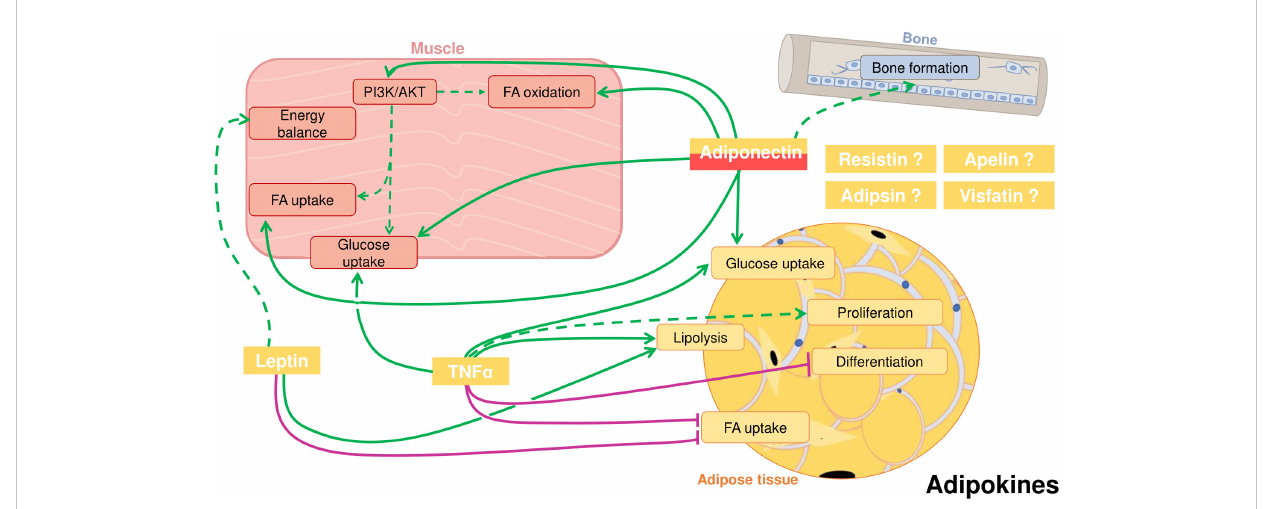
FIGURE 1 Crosstalk between adipose tissue, muscle, and bone in fi sh through cytokines secreted by the adipose tissue, also known as adipokines. Adiponectin, that can also be secreted by skeletal muscle, can positively in fl uence in muscle fatty acid (FA) and glucose uptake, FA oxidation and activate the PI3K/AKT pathway. Studies suggest a role for adiponectin inducing bone formation. Adiponectin has also autocrine functions in the adipose tissue, where it can promote glucose uptake. Leptin in muscle can presumably in fl uence energy balance. In the adipose tissue, leptin induces lipolysis and inhibits FA uptake. Tumor necrosis factor a (TNF a ) can stimulate glucose uptake in muscle and has an important autocrine role in adipose tissue. There, TNF a stimulates glucose uptake and lipolysis, and probably adipocyte proliferation, whereas it inhibits differentiation and FA uptake. Other potential adipokines are resistin, apelin, adipsin and visfatin. Positive proved effects: green solid line; Positive suggested effects; green dotted line; Negative proved effects: purple solid